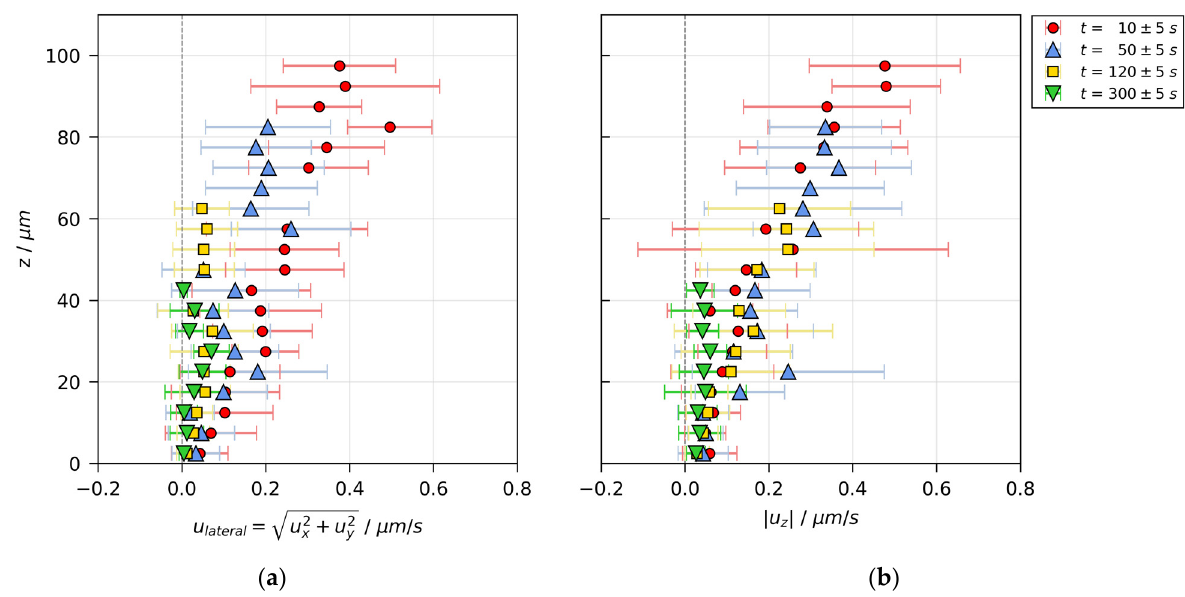
Figure 6. Velocity distribution in a poly(vinyl acetate)-methanol film ( X 0 = 1 g MeOH / g PVAc and h gap = 200 µ m ), drying at T substrate = 20 ◦ C and otherwise ambient conditions, measured with 3D- µ PTV and evaluated with mean refractive index. Data are averaged laterally and in vertical slices of ∆ z = 5 µ m. The flow field is dominated by film shrinkage. ( a ) Lateral velocity over film height. ( b ) Absolute vertical velocity over film height.